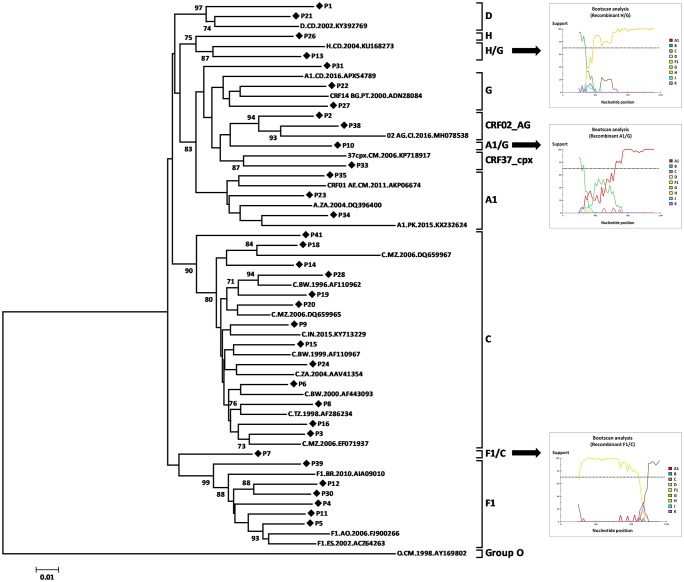
Evolutionary relationships of HIV-1 subtypes among infected pregnant women in Luanda, Angola, 2018.The analysis involved 56 nucleotide sequences. All HIV-1 strains identified in this study were from M-group. The phylogenetic tree was inferred using the NJ method, and Tamura-Nei genetic distances with 1000 bootstrap replicates. Analyses were conducted in MEGA v7.0. Bootstrap values more than 70% and recombinants strains are indicated.